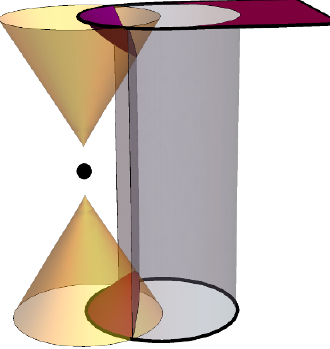
Figure 9 . A three-dimensional version of the right (cid:12)gure of (cid:12)gure 8. A L is chosen to be a circle, while A R is of a keyhole shape. The purple parts of the membrane inside the yellow cones are glued together as indicated by the grey surface. Since A L and A R do not overlap, hence we have to include a horizontal section of the membrane drawn with purple that also contributes to the